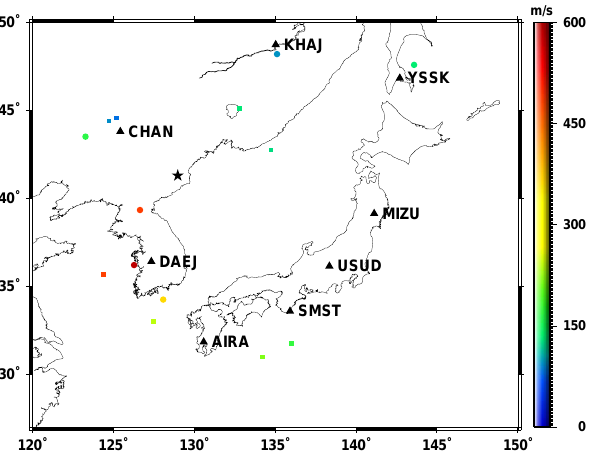
Figure 2. The locations of GPS stations (black triangles) and IPPs of detected TIDs. The black star represents the epicenter location. The circles denote the high-frequency TIDs and the squares denote the low-frequency TIDs. The color bar indicates the TIDs’ propa- gation velocities.